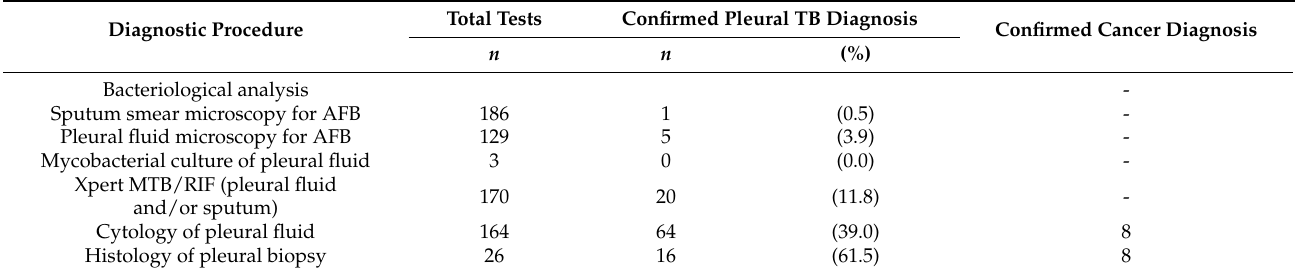
Table 1. Positivity of the tests performed and their diagnostic value among patients with presumptive TB Pleural Effusion ( n = 187).